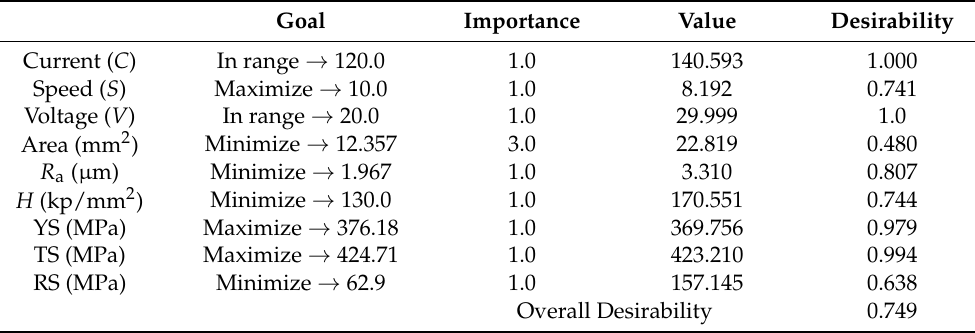
Table 11. The second criterion considered: cost based on the cord area.